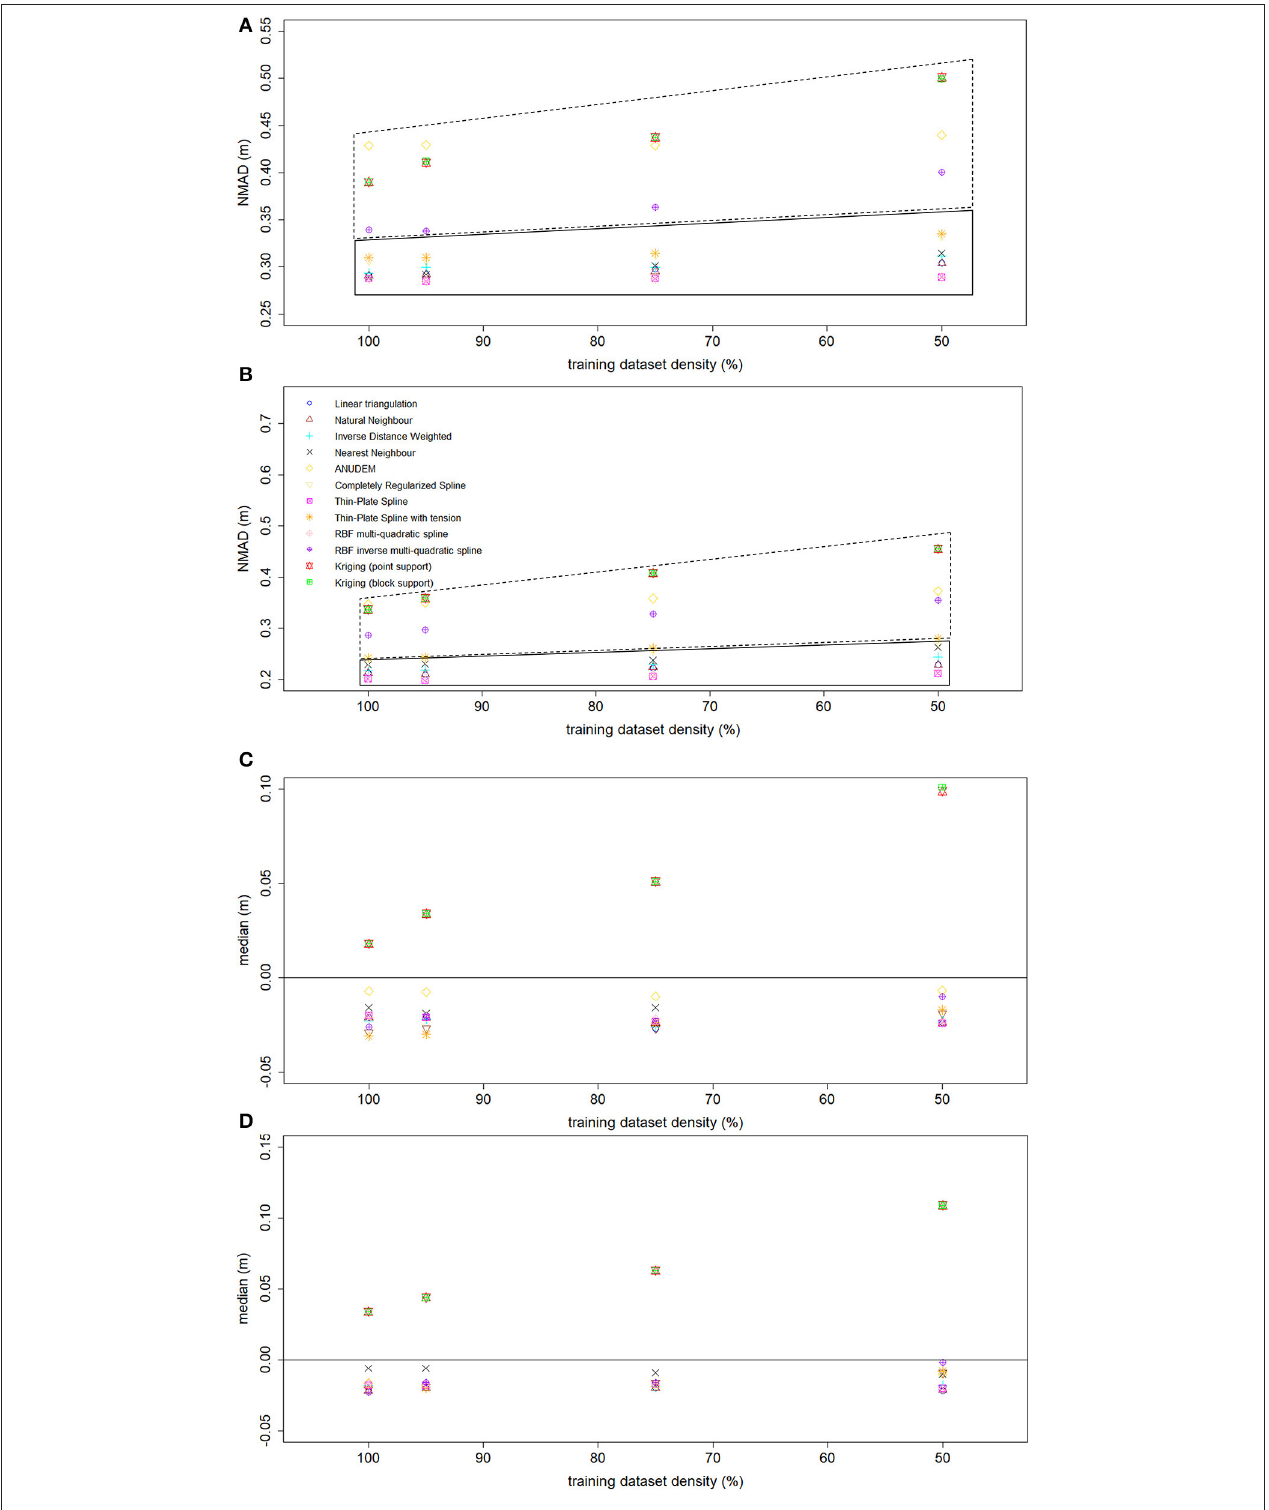
FIGURE 7 | NMAD values variation as a function of the sample density ( A , spatial resolution equal to 1.00m, and B , spatial resolution equal to 0.50m). Median values variation as a function of the sample density ( C , spatial resolution equal to 1.00m, and D , spatial resolution equal to 0.50m).